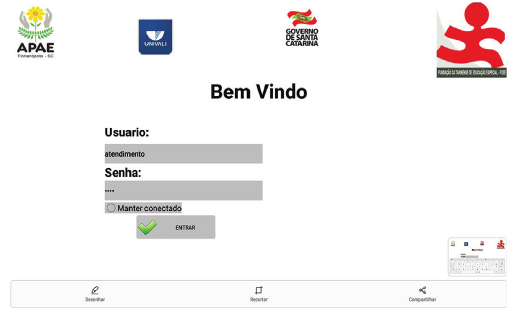
Figure 4: The welcome screen.